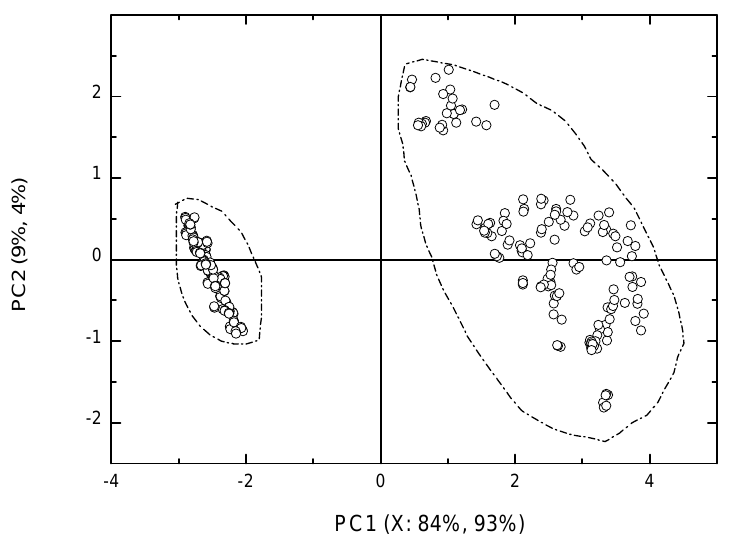
Figure 4. PLS-1 score plot of all samples in test mixtures of key odorants containing ammonium at pH 6 (to right) and at pH 8 (to left). Full cross validation, PLS-DA was used and eight electrodes were